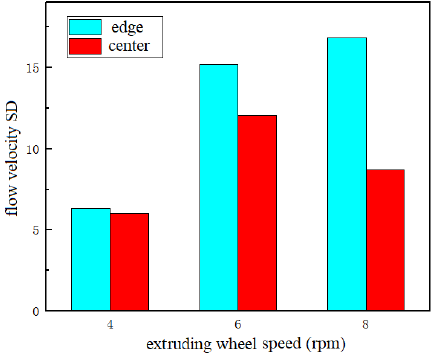
Figure 11. Flow velocity SD of different extruding speeds.